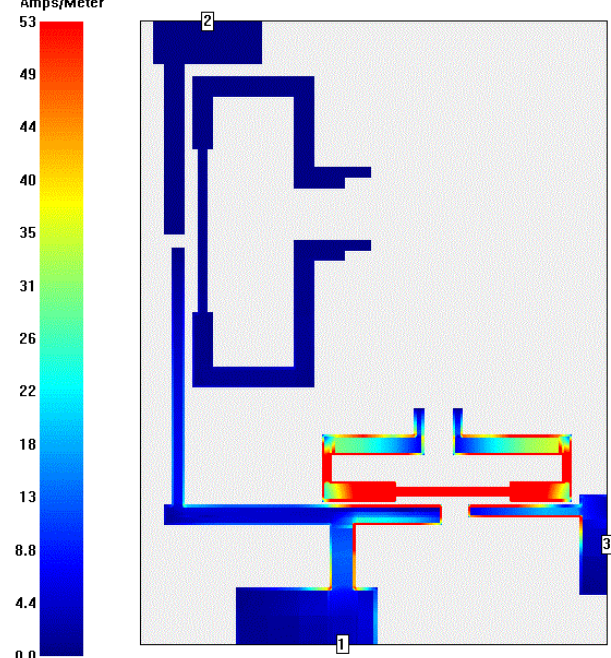
Figure 11. Current intensity distribution @ 4.08 GHz.